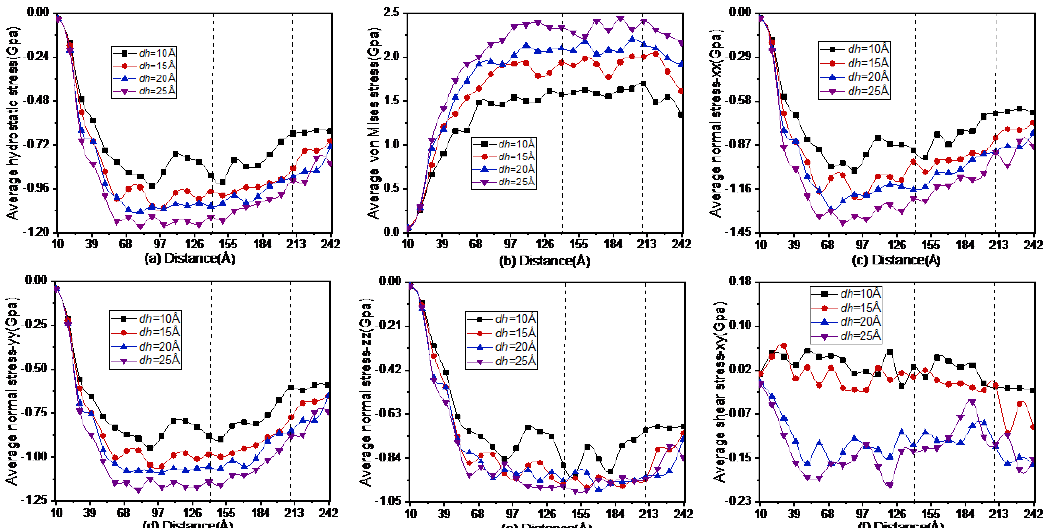
Figure 6. Evolution diagrams of the average stresses including σ hyd ( a ), σ von ( b ), σ xx ( c ), σ yy ( d ), σ zz ( e ) and σ xy ( f ) with the grinding distance under the specified grinding depths.